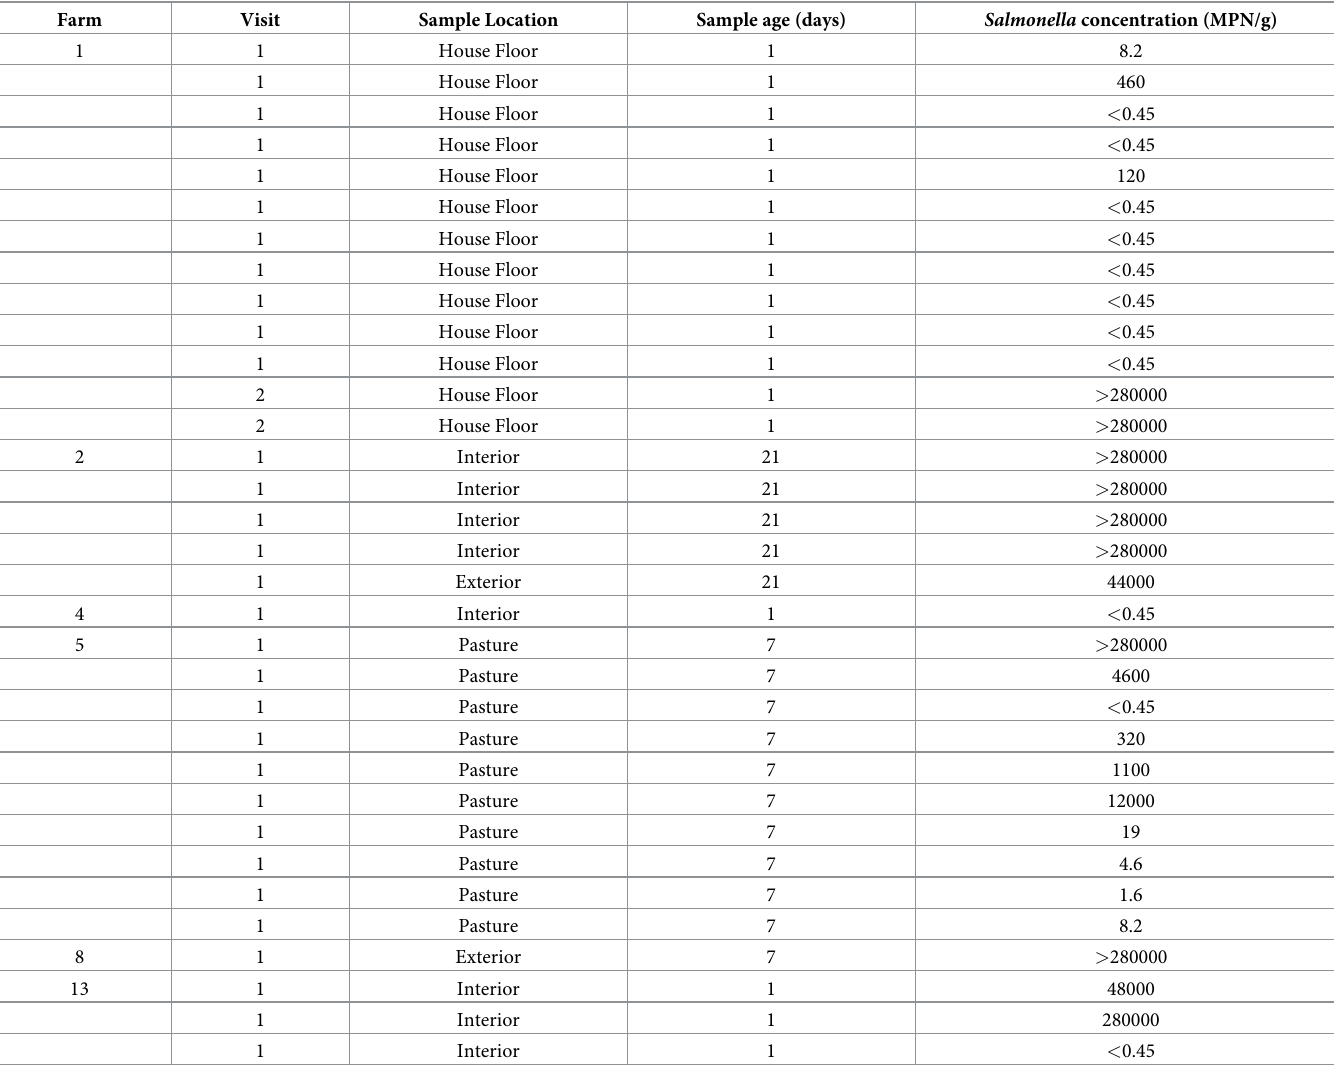
Table 2. Concentration of Salmonella in positive samples collected from piles, houses, or pastures in the southern United States. Farm